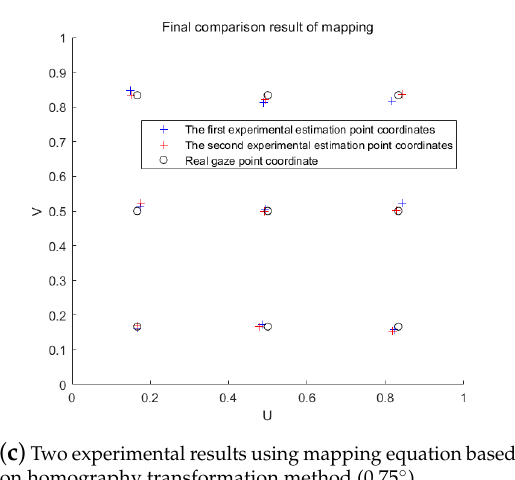
Figure 9. Comparative experimental results of the two methods.